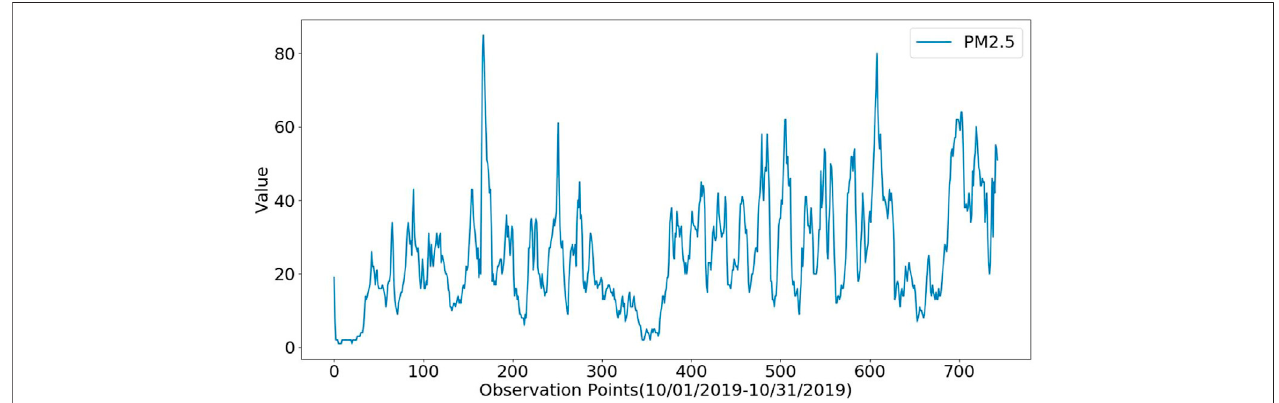
FIGURE 4 | An overview of our proposed temporal difference-based graph transformer networks (TDGTN) for air quality PM2.5 prediction.